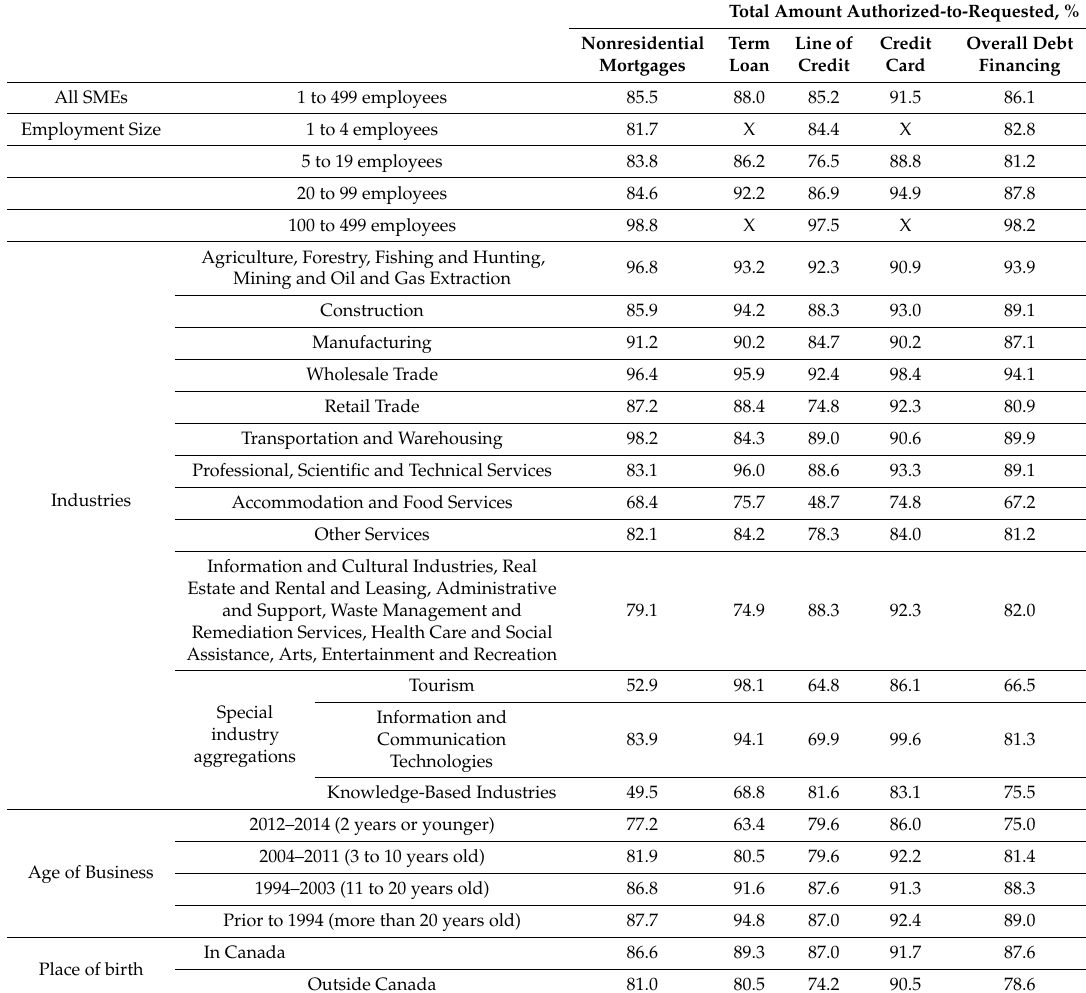
Table 1. Canadian small- and medium-sized enterprises (SMEs) debt financing.